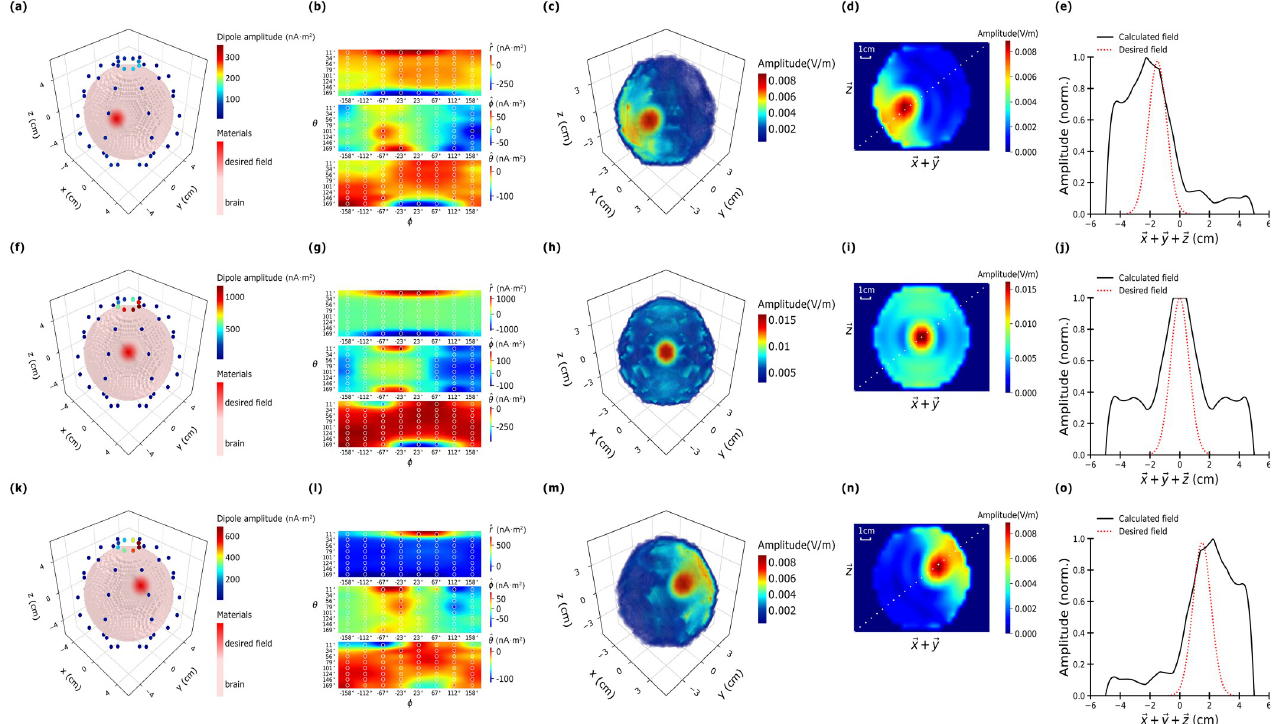
Fig 8. Spherical brain model with only brain structure with radius 5 cm using 64 dipoles at 1 GHz for different target points at (a), (d), (g) x = y = z = − 1 cm, (b), (e), (h) at x = y = z = 0, and (c), (f), (i) x = y = z = 1 cm. The material properties are consistent with gray matter and the amplitude of focusing MW field is